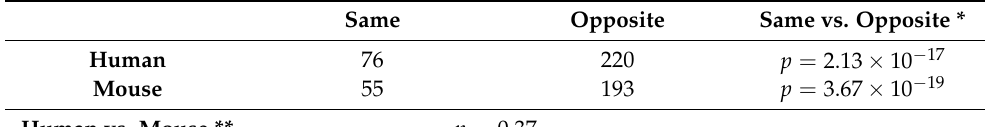
Table 1. Numbers of Simple Nested Protein-Coding Genes on the Same and Opposite